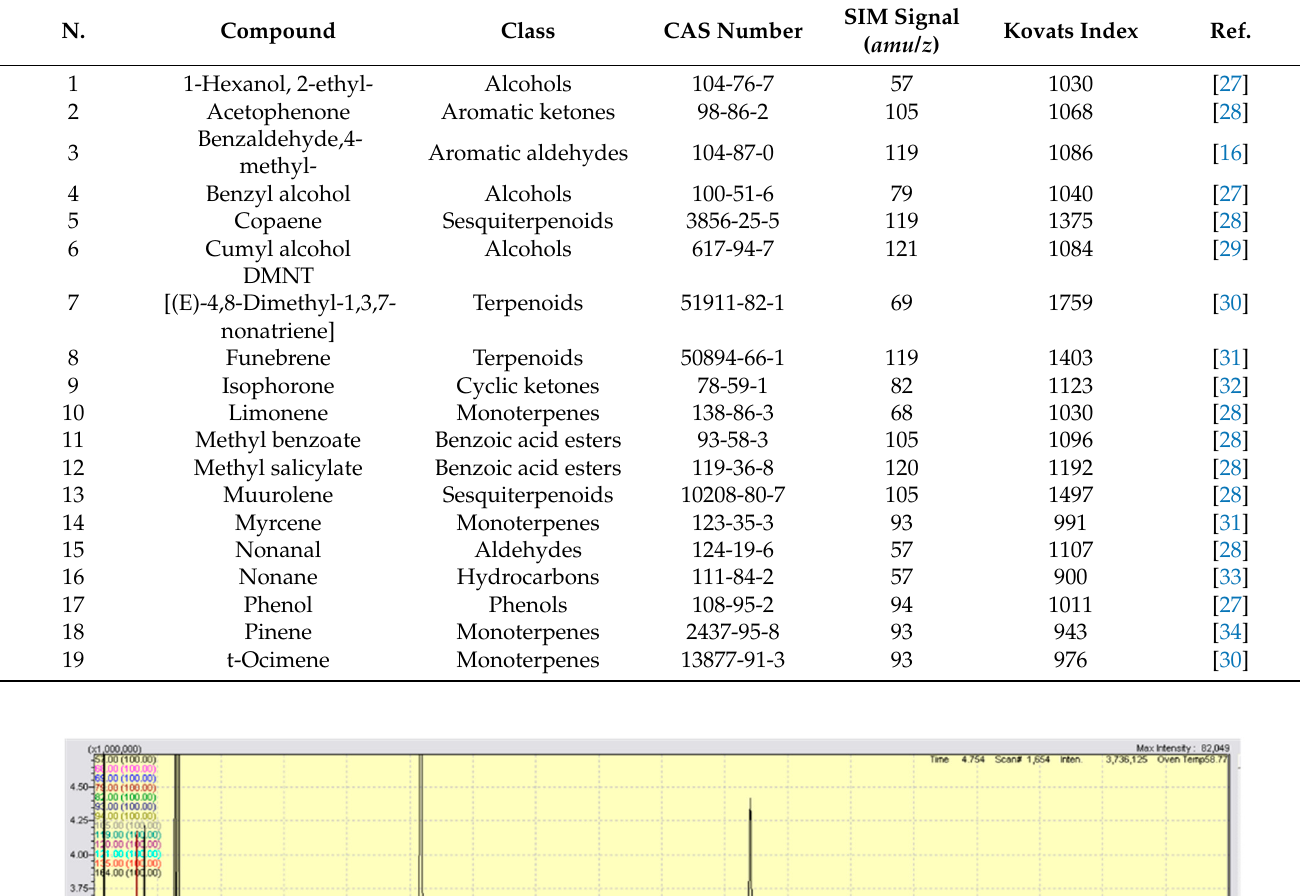
Table 2. List of specific olive tree volatile compounds found in this study and the parameters used for their identification. N.